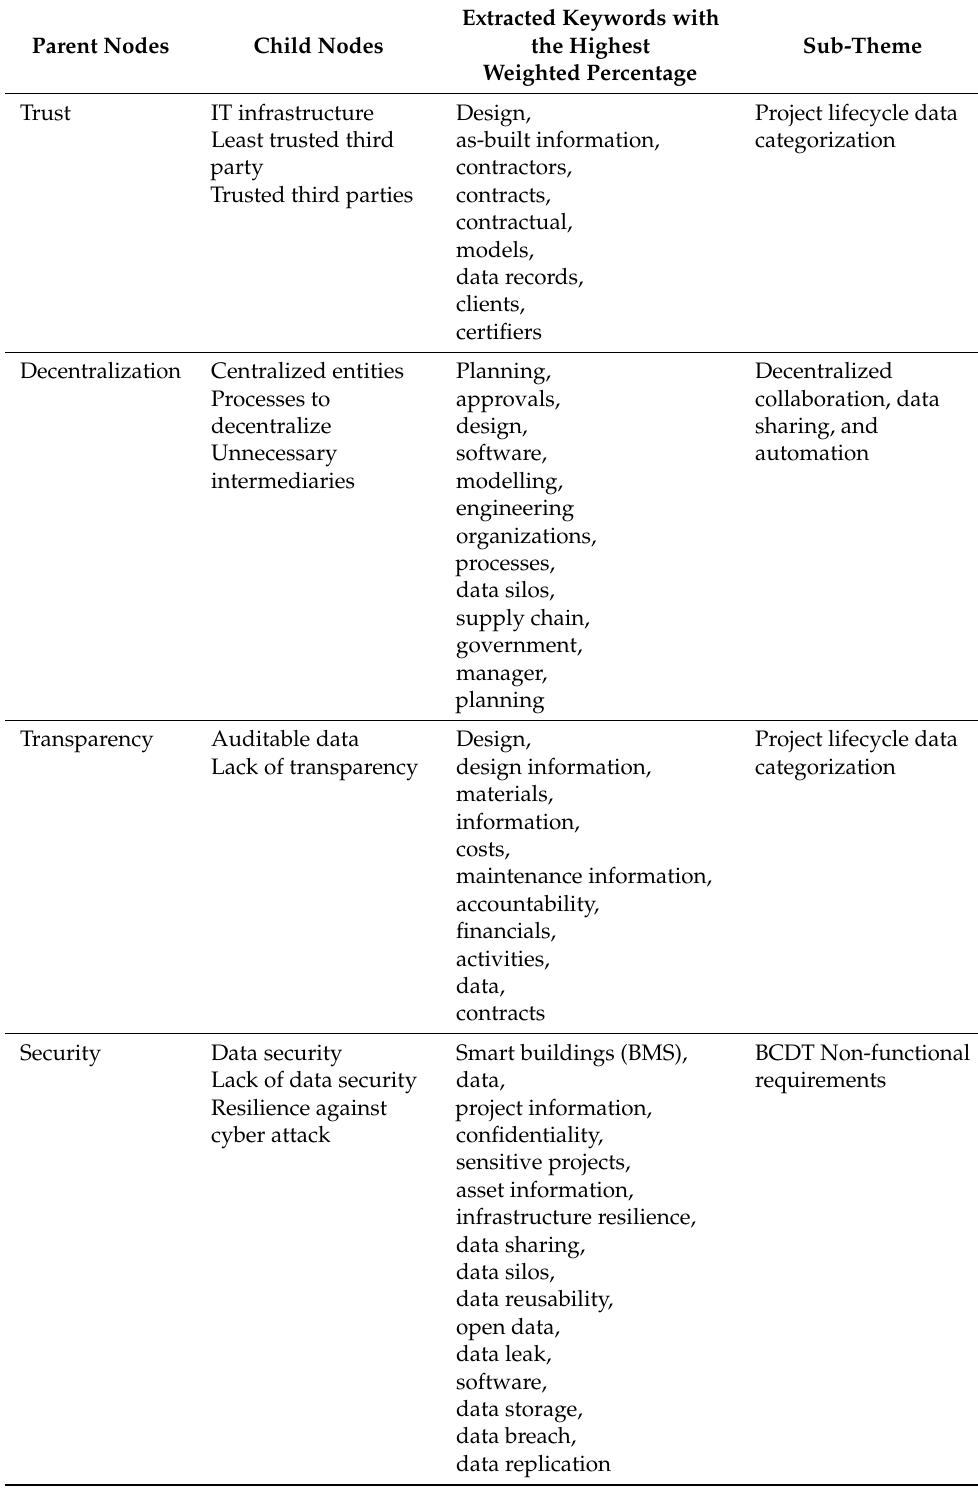
Table 8. A summary of coding analysis including parent and child nodes identified from the